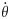
Swing task.The model represents repositioning of the swing leg as part of the response to a trip. (a) We modeled the swing task as a distributed mass pendulum actuated by muscle torque Tmusc. Our model incorporates the distance from the pendulum pivot to limb center of mass (LCOM), mass of the limb (Mlimb), and moment of inertia of the forelimb about the shoulder joint (MOI). (b) Angle (θ), angular velocity (θ˙), and torque (Tmusc) profiles in the swing task for a one kg animal for a 30 degree movement, the movement magnitude for which inertial delay equals sensorimotor delay in a one kg animal. (c) Variation in coefficient a and exponent b of the power law for inertial delay from numerical simulations with movement magnitude (dark blue), sensorimotor delay (dark green), and theoretical predictions for the inertial delay exponent based on scaling of muscle force with cross-sectional area ∝M2/3 (thick dashed line) and dynamic similarity ∝M1 (thin dashed line).